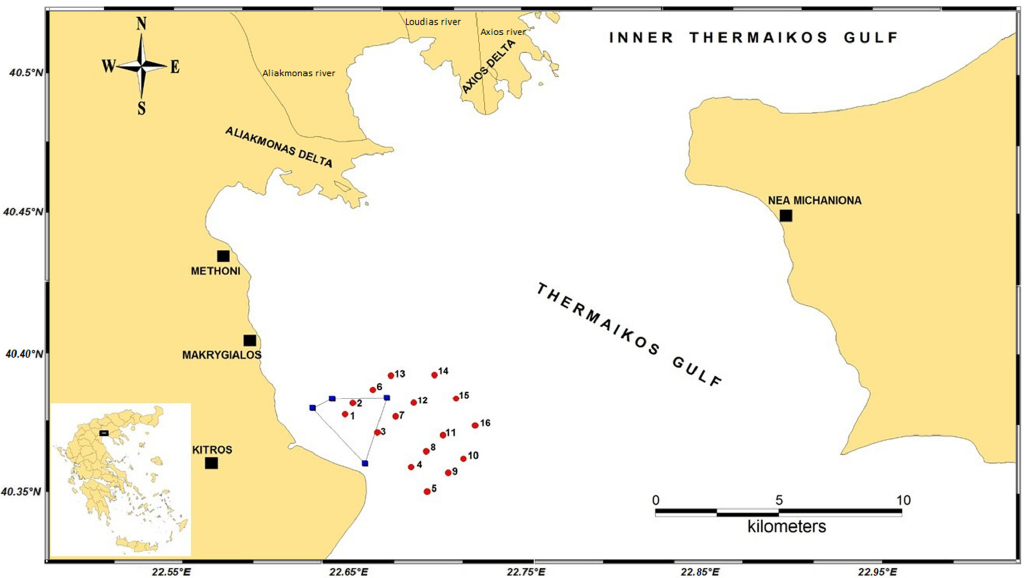
Figure 1. Sample sites ( N = 16) for environmental and ichthyoplankton data collection in the outer Thermaikos Gulf of the Aegean Sea offshore of the coastal zone of Kitros, in the Pieria region of Greece. Field sites were located on edge habitats of a previously constructed artificial reef complex (polygon with blue